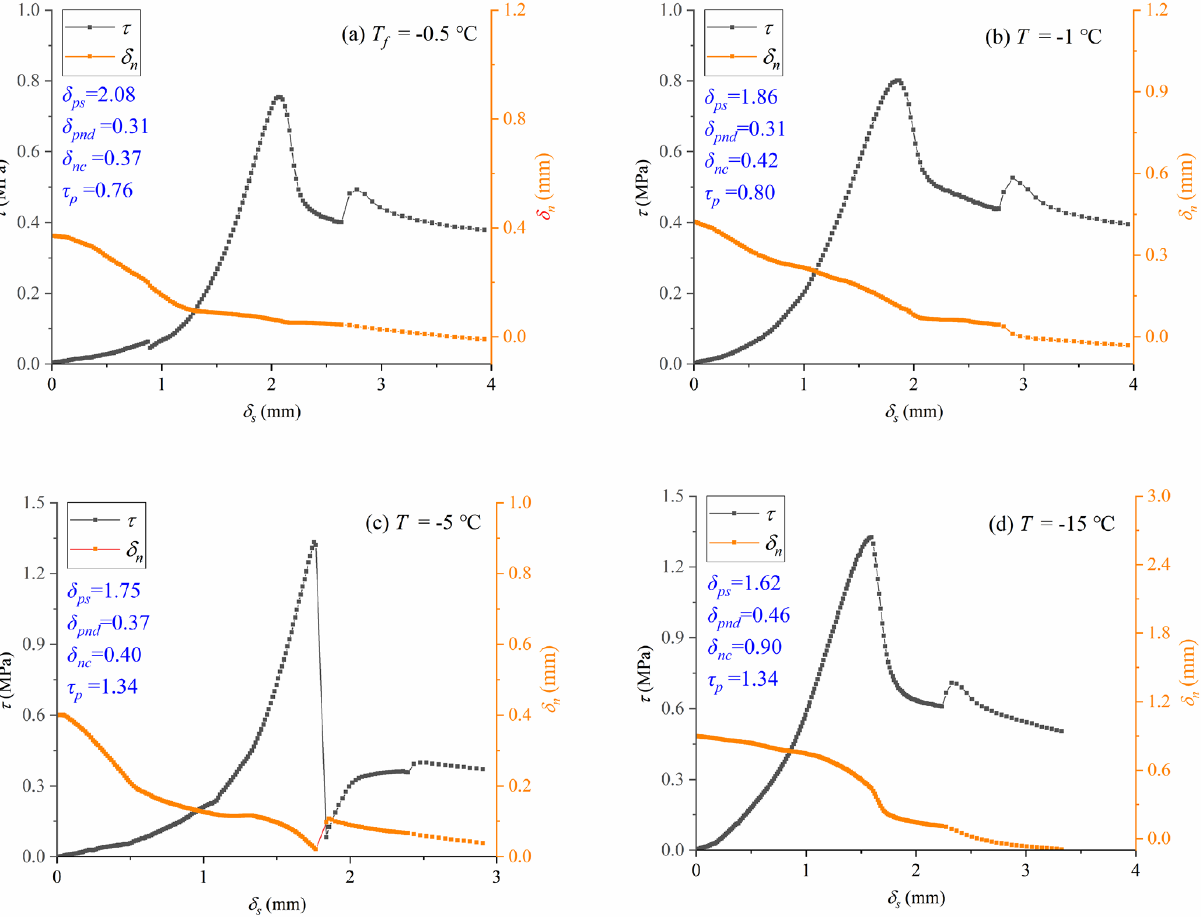
Figure 9. Shear strength and normal displacement versus the shear displacement for profile no. 4 in the temperature group. δ ps and δ pnd are the shear displacement and normal shear dilatancy at the point of peak shear strength, τ p , and δ nc is the initial compression